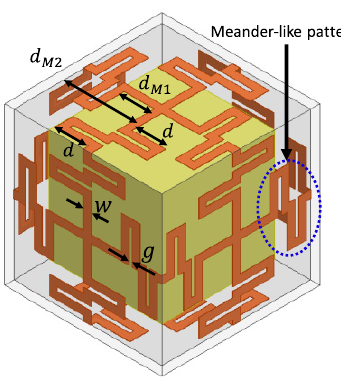
Fig. 7. Schematic of cube-shaped unit cell block of 3-D quasi- isotropic metamaterial including a dielectric cube and printed meander-line patterns.